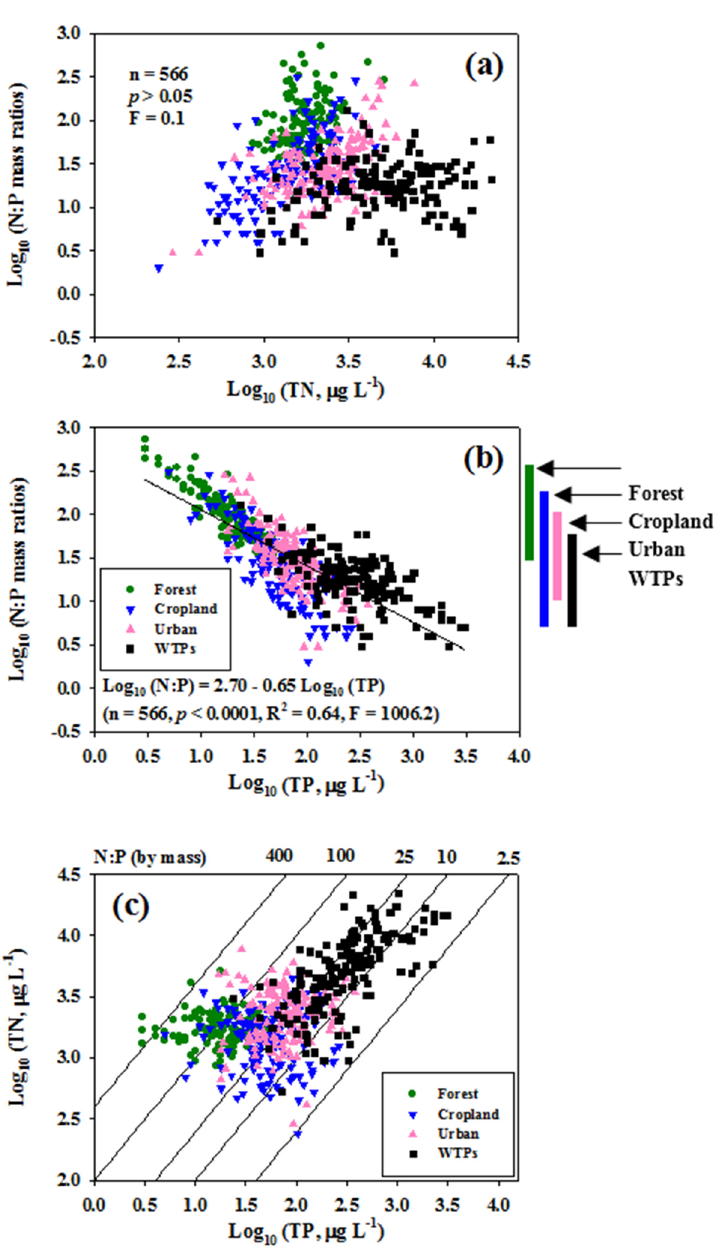
Figure 2. Relationships between log 10 -transformed N:P ratios and total nutrient concentrations (TN = total nitrogen, TP = total phosphorus), and between log 10 -transformed TN and TP in the Geum River. ( a ) log 10 (TN)–log 10 (N:P mass ratios); ( b ) log 10 (TP)–log 10 (N:P mass ratios); and ( c ) log 10 (TP)–log 10 (TN). Vertical bar (right side of panel b) indicates N:P mass ratios on the relations of TN vs. TP among the different land uses.